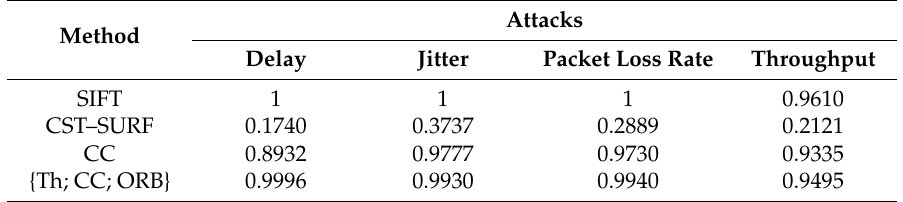
Table 17. The average F1-scores for the different transmission attacks in the ReTRiEVED dataset.